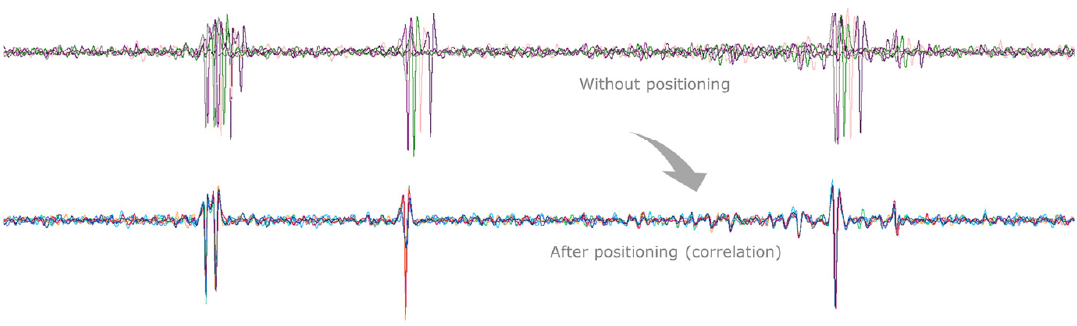
Figure 2. Input and output of the positioning algorithm. Figure 2 . Input and output of the positioning algorithm .